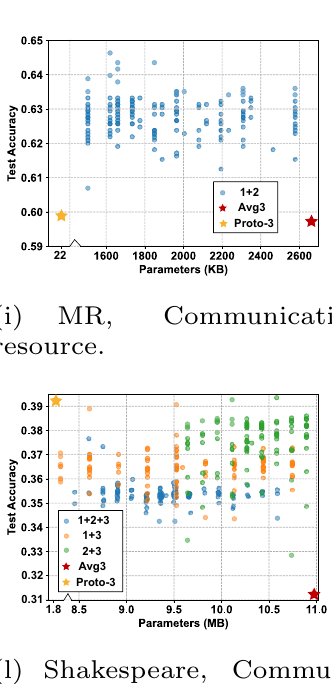
Cifar10, Calculation resource.